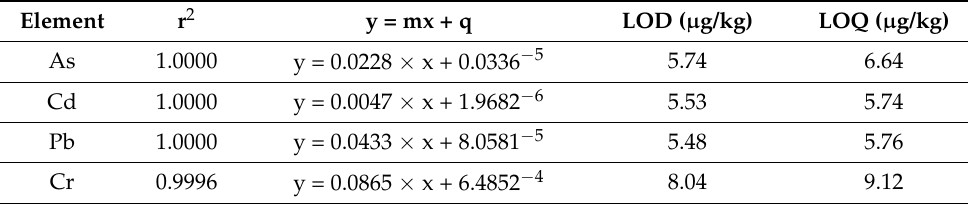
Table 1. ICP-MS calibration results of the ICP-MS method and LOD-LOQ values of the trace elements analysed.